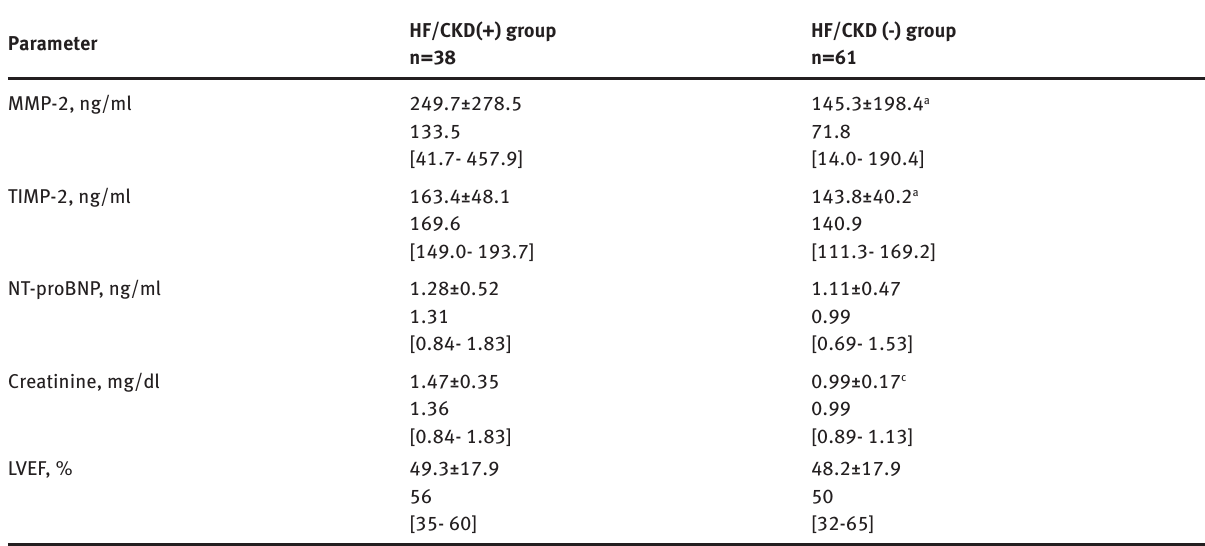
Table 5: The serum levels of MMP-2, TIMP-2, NT-proBNP, creatinine, and LVEF in HF/CKD(+) versus HF/CKD(-) group (classification according to eGFR).